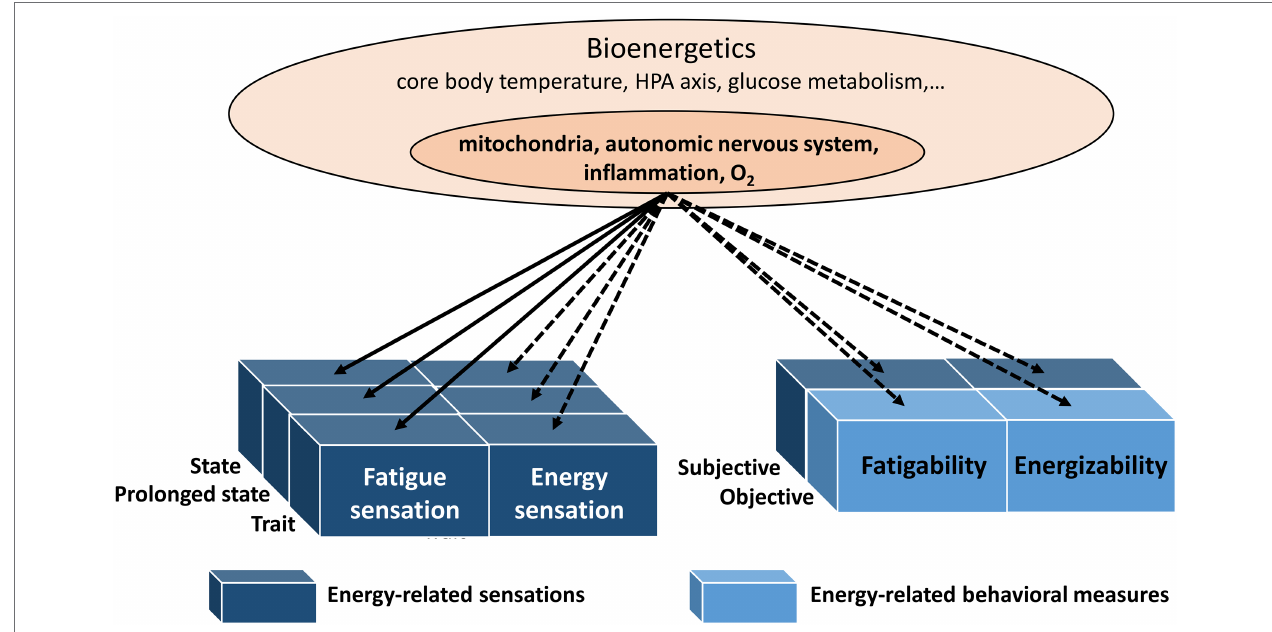
FIGURE 3 | The bioenergetics components and their link with fatigue sensations, energy sensations, energizability, and fatigability. Solid lines: reviewed here. Dashed lines: not reviewed here. All these bioenergetic components may be linked to behavioral markers (see objective fatigability) and sensations (see subjective fatigability; fatigue and energy sensations). The concept of energizability has been newly introduced and subjective fatigability has been